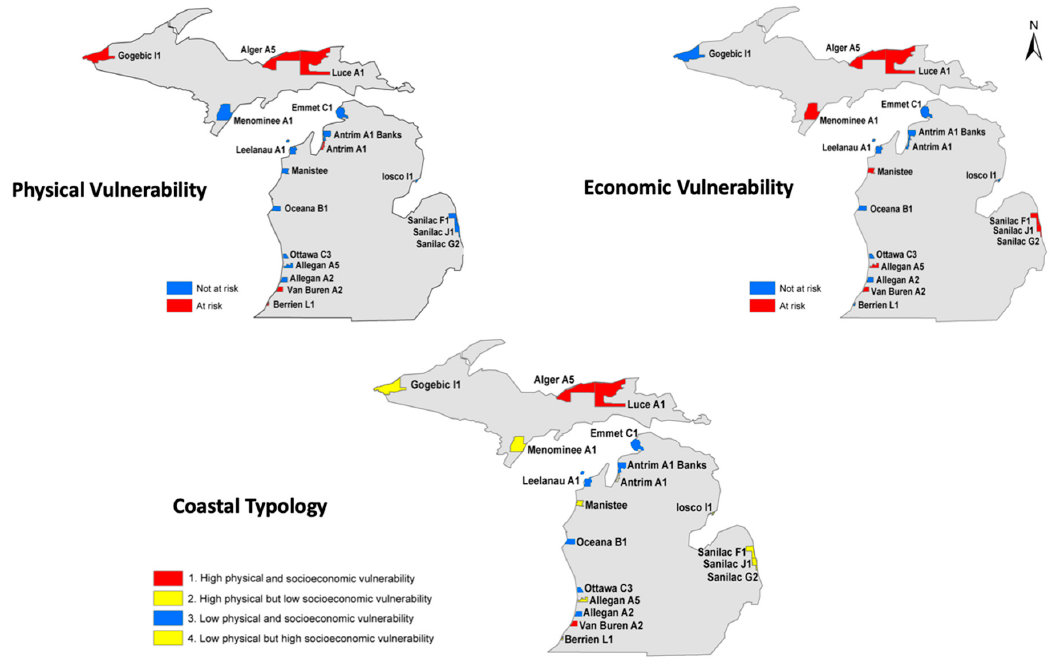
Figure 4. Physical and Socioeconomic Vulnerability from 2005–2010. Note: The colors are designed to match the typology in Figure 3.